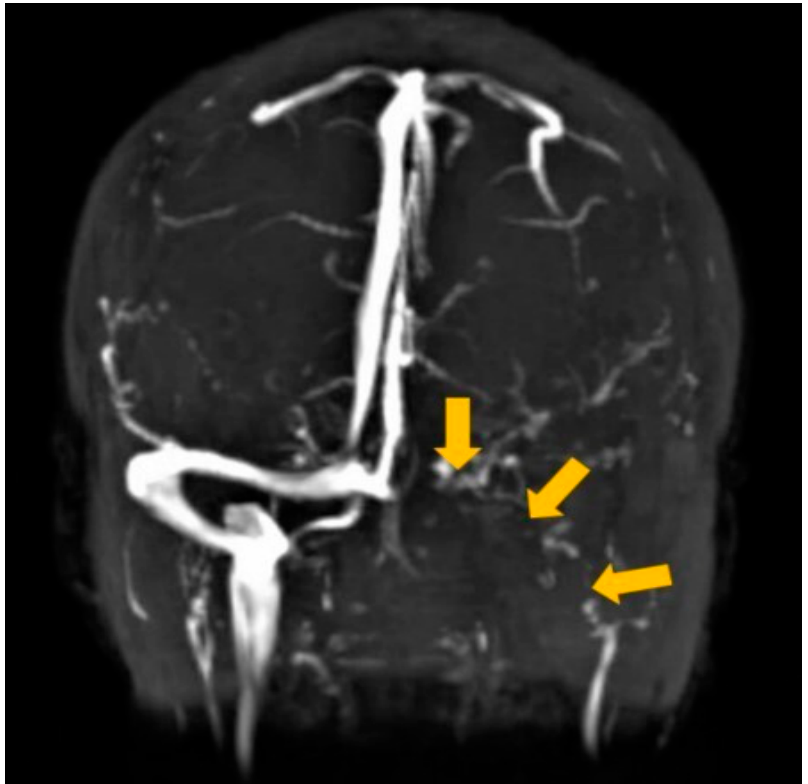
Figure 2. Magnetic resonance venography (MRV) on admission revealed a lack of flow-related signal in the left transverse sinus, correlating with dense vein sign seen on non-contrast head computed tomography (CT), confirming the presence of cerebral venous thrombosis. Additionally, there was evidence of hypoplasia in the sigmoid sinus and jugular bulb.